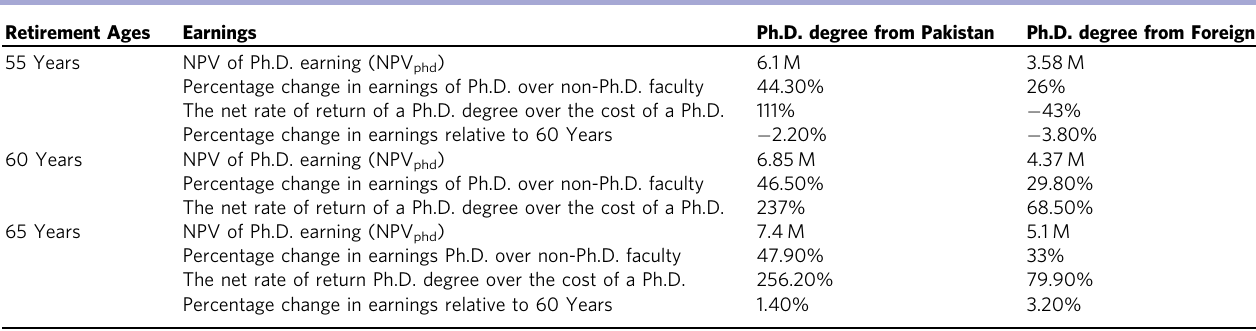
Table 10 NPV of earnings of Ph.D. degree at alternative retirement ages.